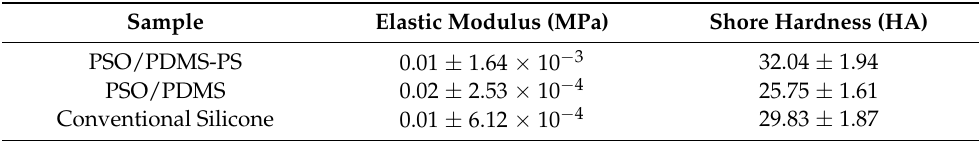
Figure 6. ( a ) The stress–strain curve of the PSO/PDMS-PS, PSO/PDMS and conventional silicone. ( b ) Elastic modulus of the PSO/PDMS-PS, PSO/PDMS and conventional silicone. Table 3. The mechanical properties of the samples.